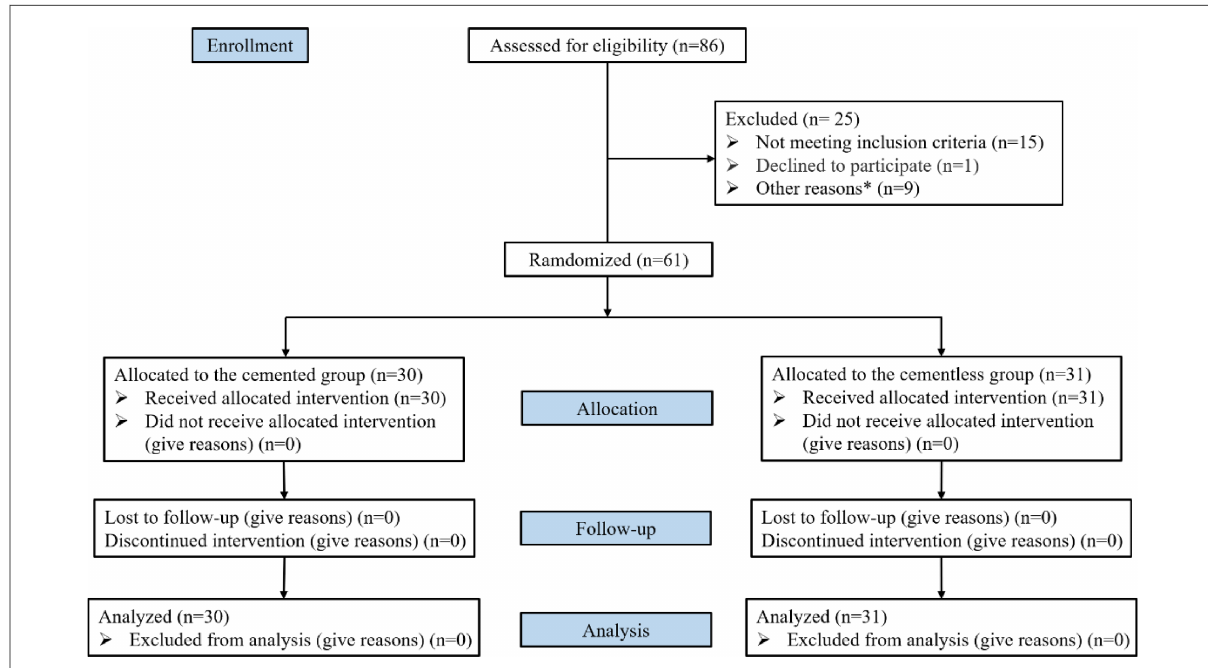
FIGURE 1 CONSORT (consolidated standards of reporting trials) fl ow diagram. Other reasons*: anticoagulant drugs ( n =3), severe osteoporosis or bone defect ( n =2), hemoglobin <100 g/L or CRP>10 mg/L ( n =2), uncontrolled hypertension ( n =1), acupuncture or puncture 3 months before surgery ( n